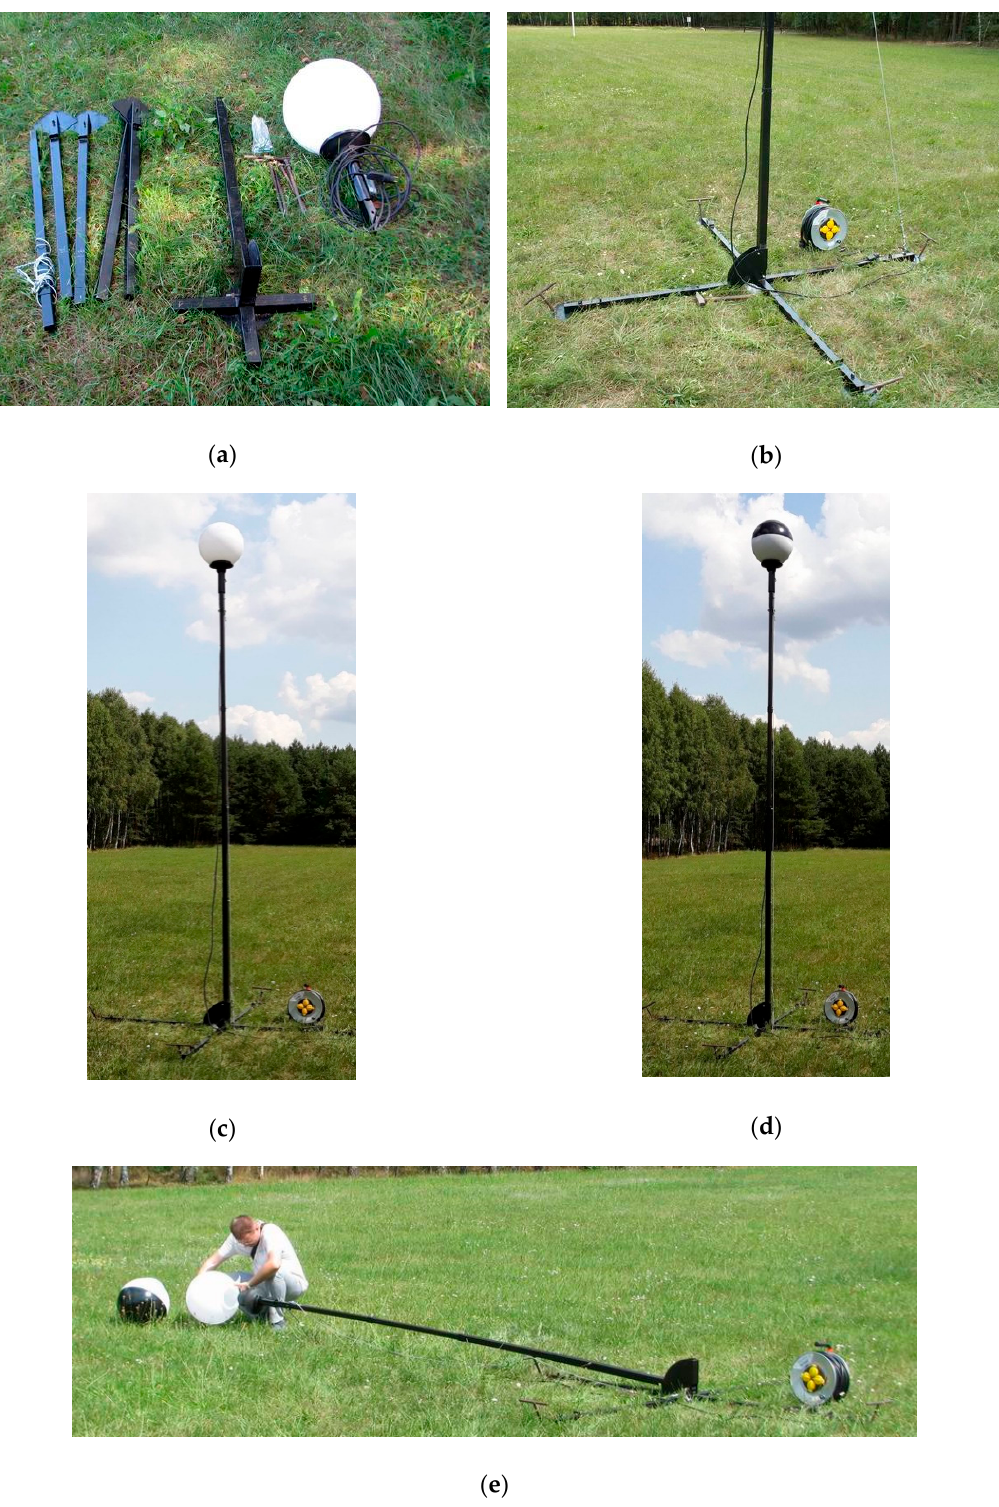
Figure 4. ( a ) Lamp post components, ( b ) base, ( c , d ) complete lamp post, and ( e ) shade replacement.